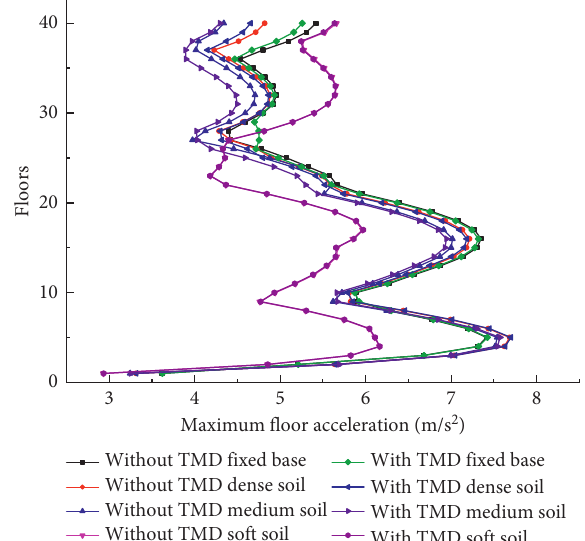
Figure 13: EL Centro earthquake peak acceleration comparison